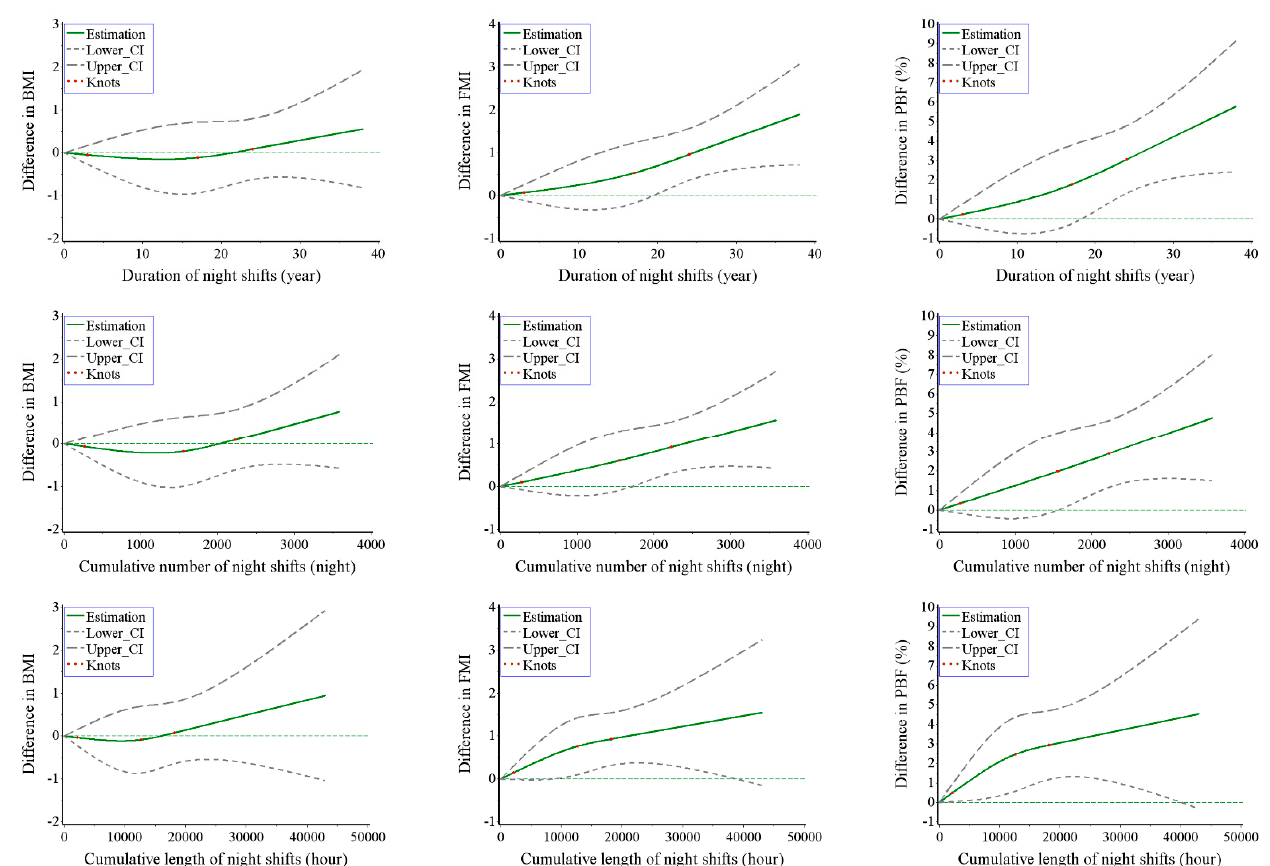
Figure 2. Associations of duration of night shifts (continuous), cumulative number of night shifts (continuous), and cumulative length of night shifts (continuous) with BMI, FMI, and BF%. The solid green lines, the long gray dashes, and the short gray dashes represent the point estimate of the difference and the upper and lower limits of its 95% CI, respectively. Knots are represented by red dots. “Difference in BMI (FMI or BF%),” represents the difference in BMI (FMI or BF%) between night shift workers with any value of duration of night shifts (cumulative number or cumulative length of night shifts) with day workers. Adjusted for age, smoking status, drinking status, education level, ethnicity, bedroom ambient light level, sleep duration, insomnia, sedentary behavior, DASH score, physical activity, marital status, menopausal status, and current use of oral contraceptives. BMI, body mass index; BF%, body fat percentage; FMI, fat mass index; CI, confidence interval.